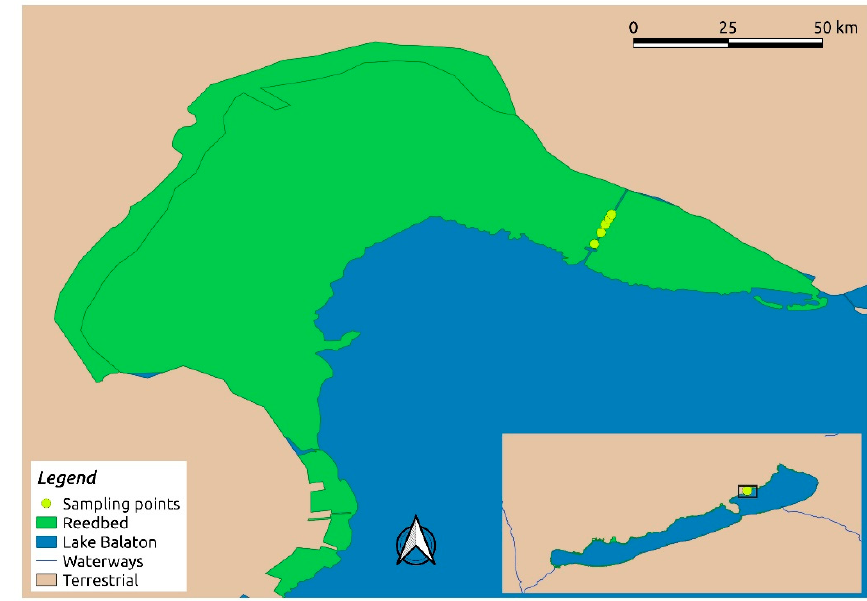
Figure 1. Map of the study area in Lake Balaton (inset) and field sampling points’ location in the Kerekedi Bay (main).